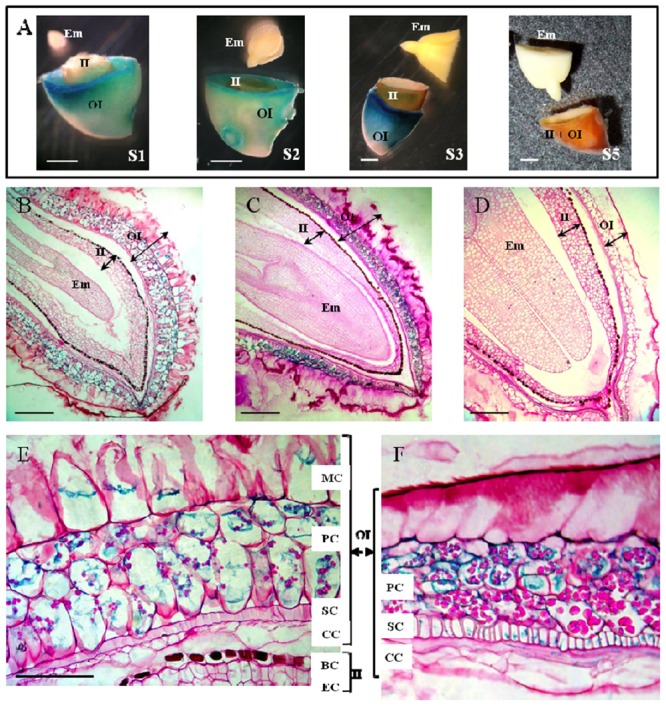
Histochemical studies of the localization of LuPLR1 promoter-driven GUS gene expression in transgenic flaxseed at different developing stages. (A)
GUS assays performed on transversely cut seeds at S1, S2, S3 and mature seeds. Bars represent 1 mm. (B–D) Semi-thin sections (5 μm) of S2 (B, longitudinal), S3 (C, longitudinal) and S5 (D, transverse) seeds assayed by GUS activities. Bars represent 250 μm. (E,F)
GUS staining in semi-thin sections (5 μm) of S2 (E) and S3 (F) seed coats. Bars represent 50 μm. OI, outer integument (Part B); II, inner integument (Part A); Em, embryo. MC, mucilaginous cell; PC, parenchymatous cell; SC, sclerified cell; CC, compressed cell; BC, brown cell; EC, endosperm cell.